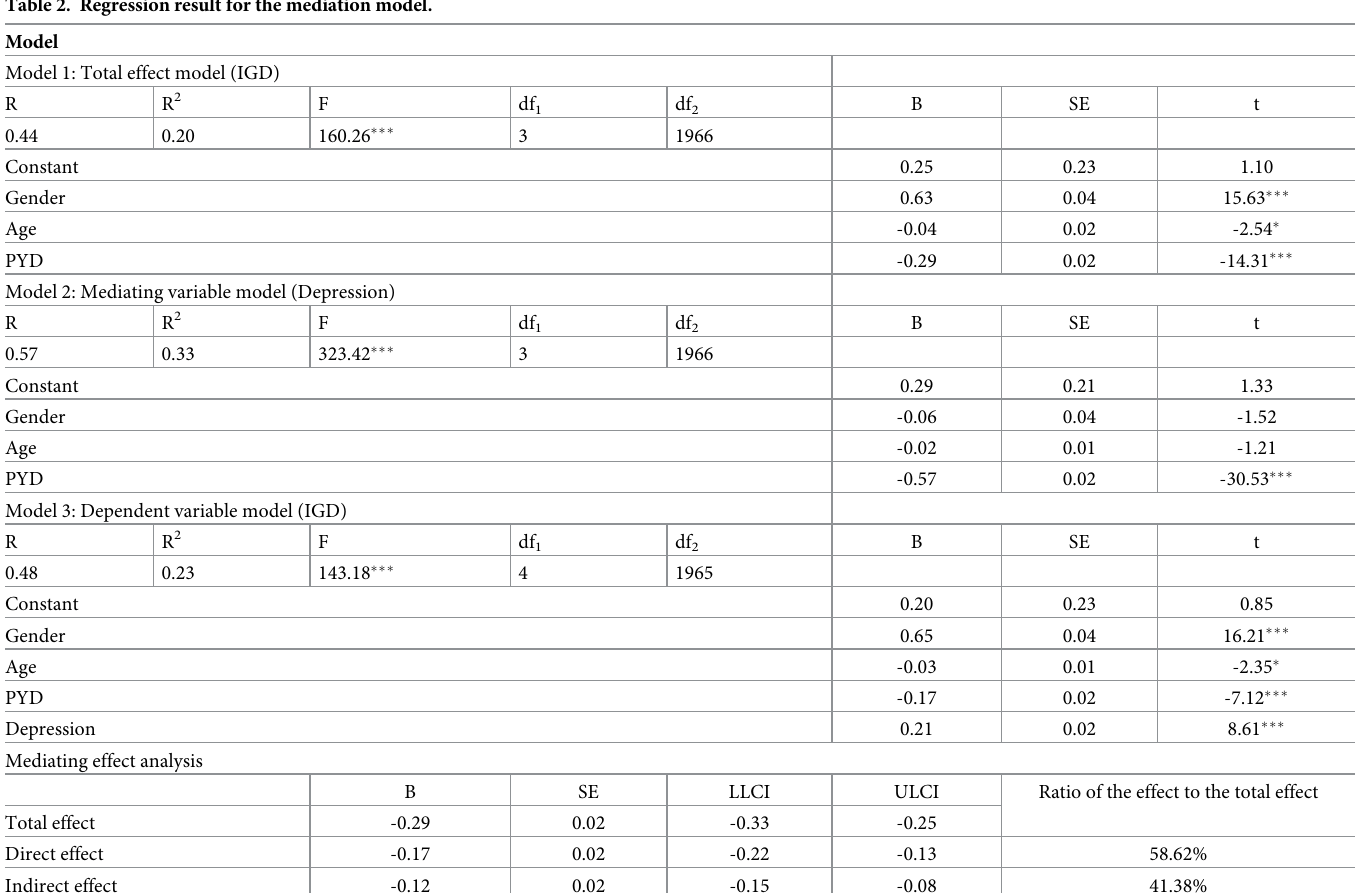
Table 2. Regression result for the mediation